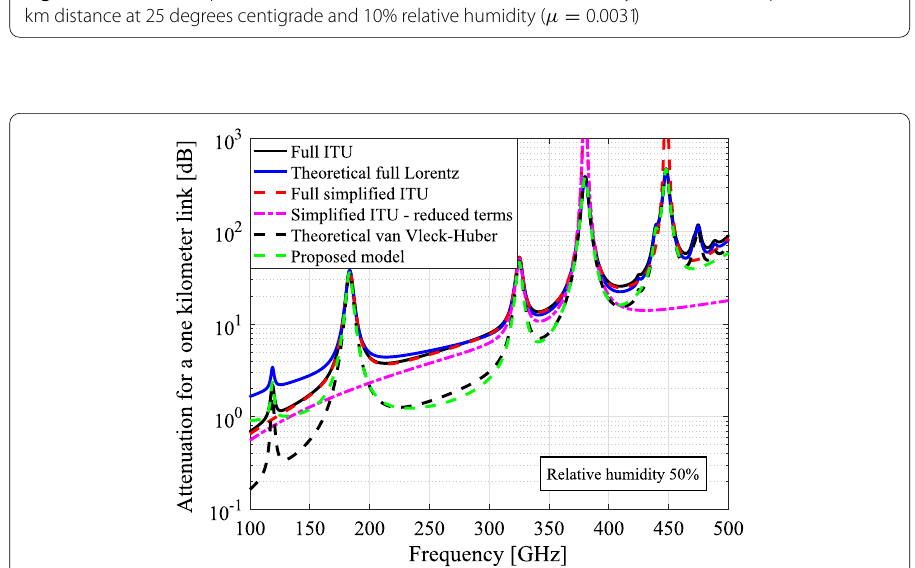
Fig. 3 Molecular absorption loss at 1 km distance. Molecular absorption loss at 1 km distance at 25 degrees centigrade and 50% relative humidity ( µ = 0.0157